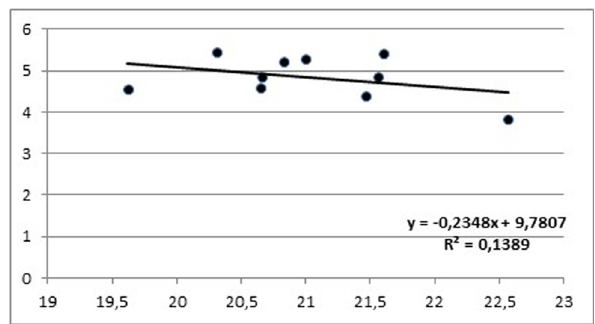
Figure 6: Linear approximation of the dependence of the meat content on the fat content in the dorsal - lumbar third of the carcass at a slaughter weight 110 kg.